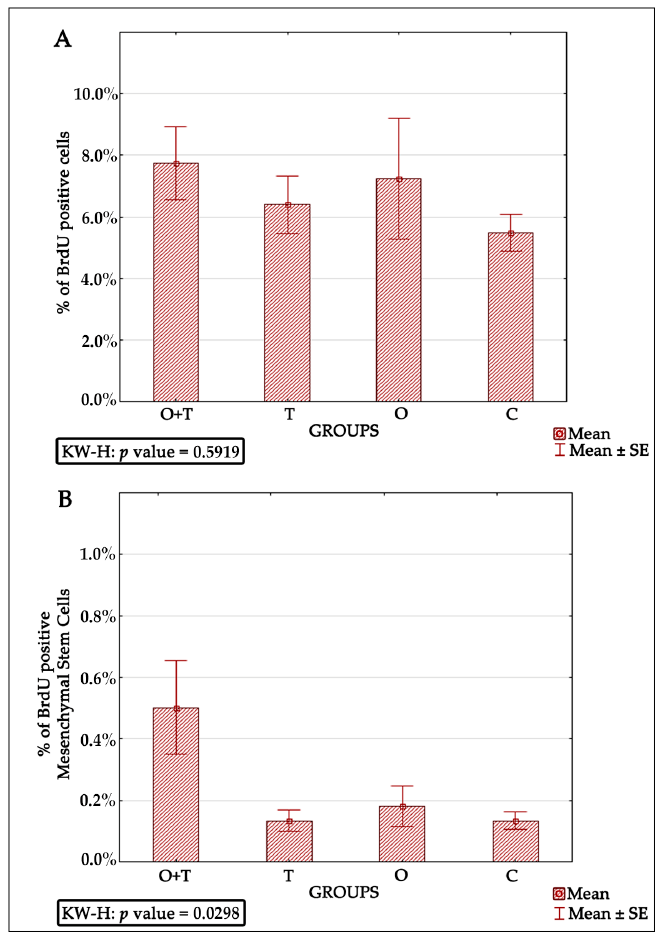
Figure 6. ( A ) Graph of the percent of the total mononuclear cell number assessed by identifying BRDU- positive cells. Kruskal-Wallis statistical test, p value = 0.05919; and ( B ) Graph of the percent of the MSCs with BRDU-positive cells and the result of the Kruskal-Wallis statistical test, p value = 0.0298. BRDU: Bromodeoxyuridine. Table 6. Mann-Whitney post-hoc statistical testfor the BRDU-positive MSCs. Table 6. Mann-Whitney post-hoc statistical testfor the BRDU-positive